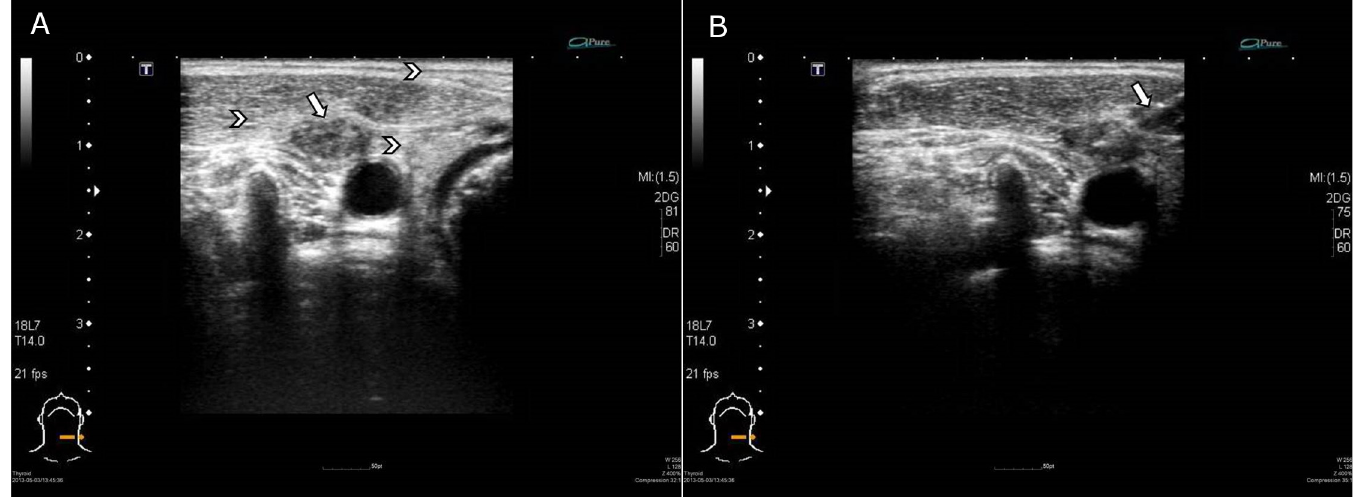
nodes between the two groups (p = 0.33). Metastatic LNs in both groups exhibited a round shape rather than a fusiform contour. Irradiated malignant LNs had a significantly decreased percentage of distinguishable calcification compared with non-irradiated malignant